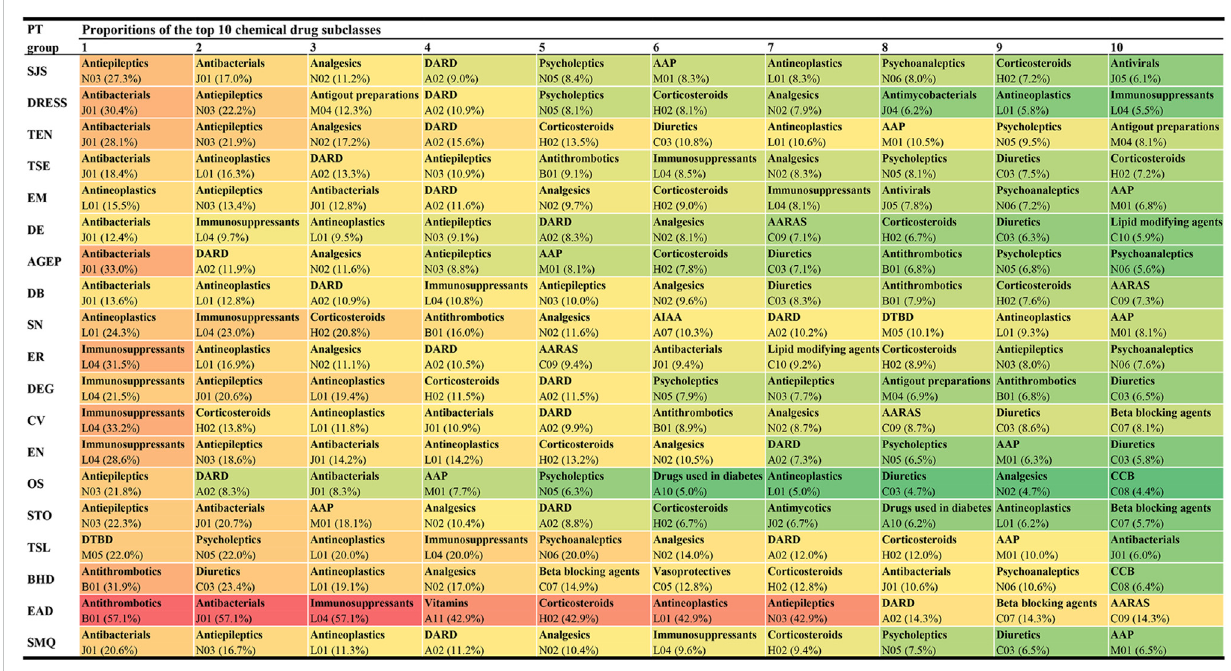
FIGURE 4 Top 10 drug classes with the highest reporting proportions at the SMQ and PT levels. AAP, antiin fl ammatory and antirheumatic products; AARAS, agents acting on the renin-angiotensin system; AIAA, antidiarrheals or intestinal antiin fl ammatory/antiinfective agents; AGEP, acute generalised exanthematous pustulosis; BHD, bullous haemorrhagic dermatosis; CCB, calcium channel blockers; CV, cutaneous vasculitis; DARD, drugs for acid related disorders; DB, dermatitis bullous; DE, dermatitis exfoliative; DEG, dermatitis exfoliative generalized; DRESS, drug reaction with eosinophilia and systemic symptoms; DTBD, drugs for treatment of bone diseases; EN, epidermal necrosis; EM, erythema multiforme; EAD, erythrodermic atopic dermatitis;ER,exfoliativerash;OS,oculomucocutaneoussyndrome;PT,preferredterm;SCARs,severecutaneousadversereactions;SMQ,Standardized MedDRA Queries; STO, SJS-TEN overlap; SN, skin necrosis; SJS, Stevens-Johnson syndrome; TSL, target skin lesion; TEN, toxic epidermal necrolysis; TSE, toxic skin